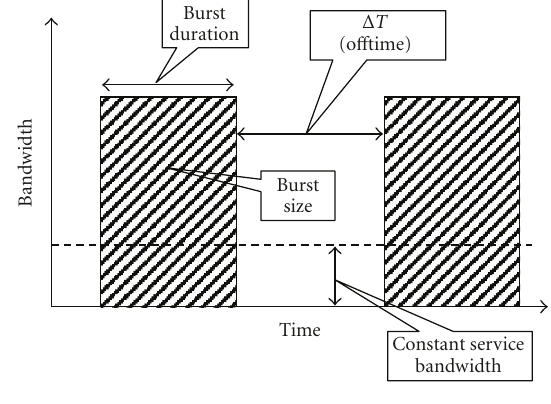
Figure 3: Time slicing in